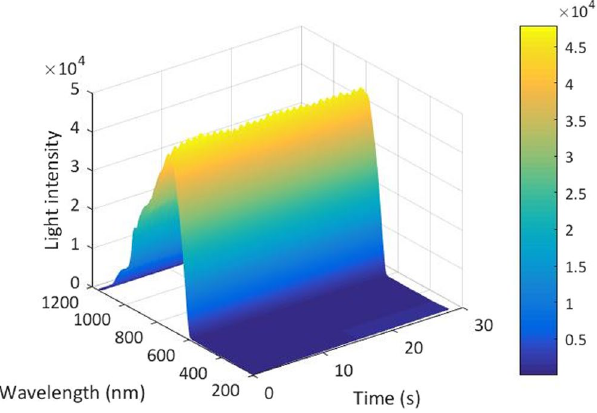
Figure 5. Original signals sampled by the spectrometer of one subject.